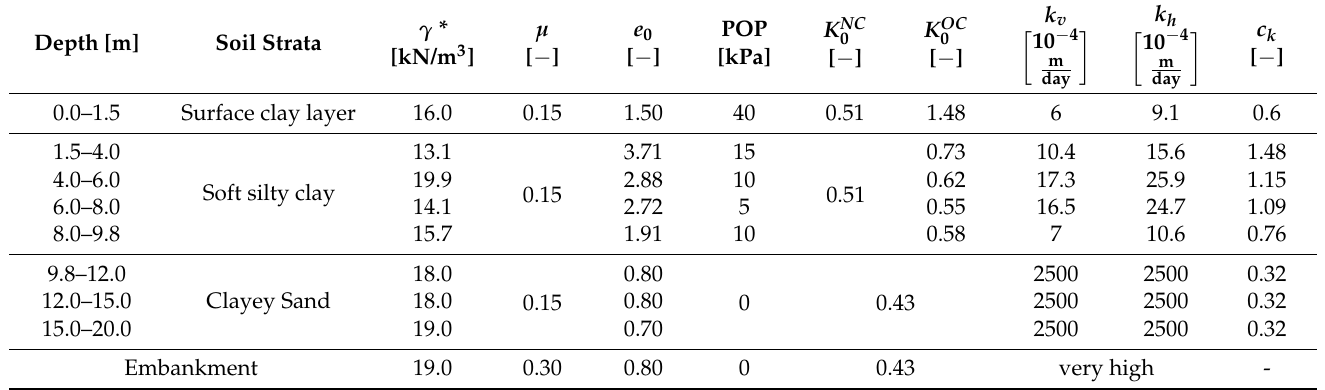
Table 1. Numerical model parameters for Embankment A.